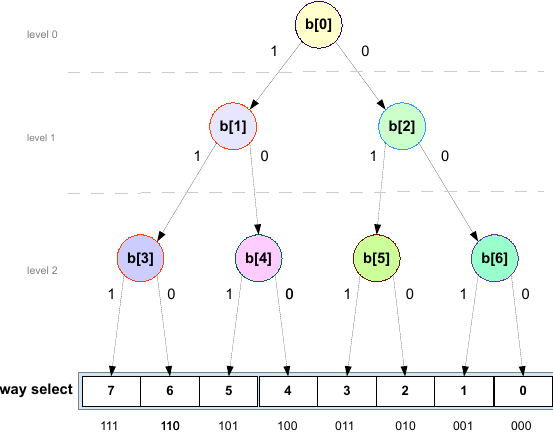
Figure 5. PLRU binary